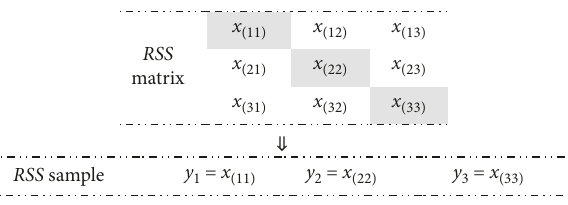
Figure 2: Display of m 2 observations in one cycle and the selected RSS sample of size m �